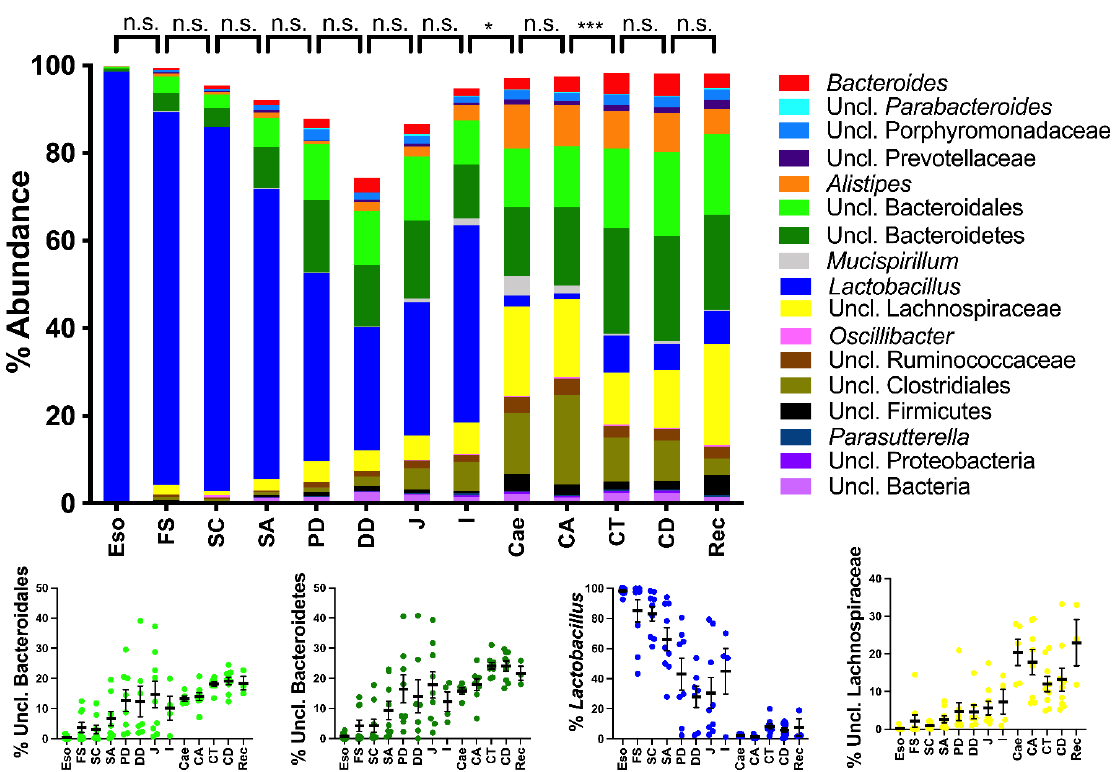
Figure 3. Relative abundance of bacterial microbiota along the alimentary tract of Tff3 KO mice. For details see the legend of Figure